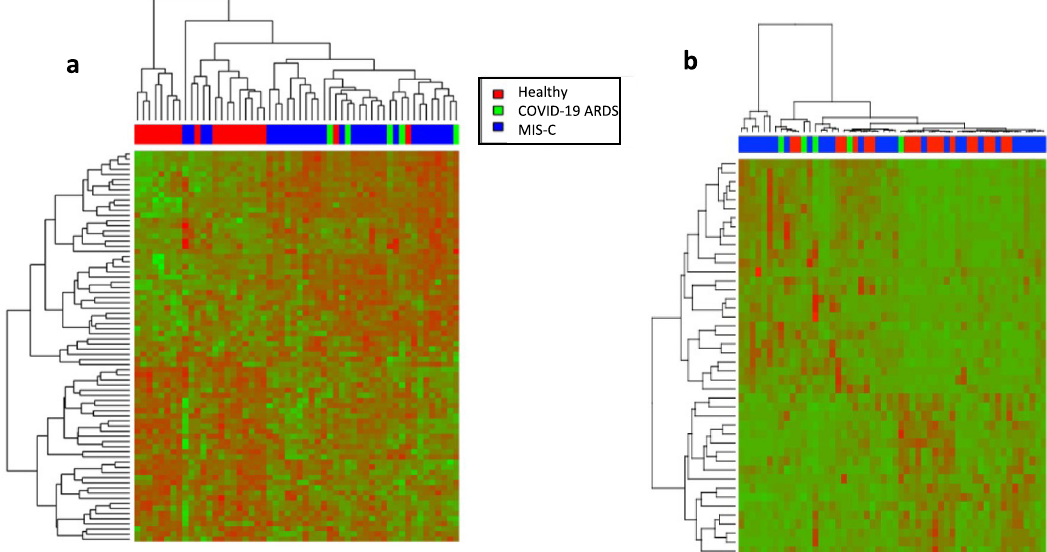
Fig. 2 Overall differentially expressed proteins. a Heatmap of the 76 differentially expressed proteins from the local assay library identi fi ed using unadjusted p value and fold-change with two-sided t test. The clustering patterns were obtained using a Euclidean-based distance and complete linkage; Green: proteins with decreased expression; Red: proteins with increased expression; b Heatmap of the 44 differentially expressed proteins from the local assay library identi fi ed using p values adjusted for multiple comparisons by using two-sided t test with Benjamini-Hochberg